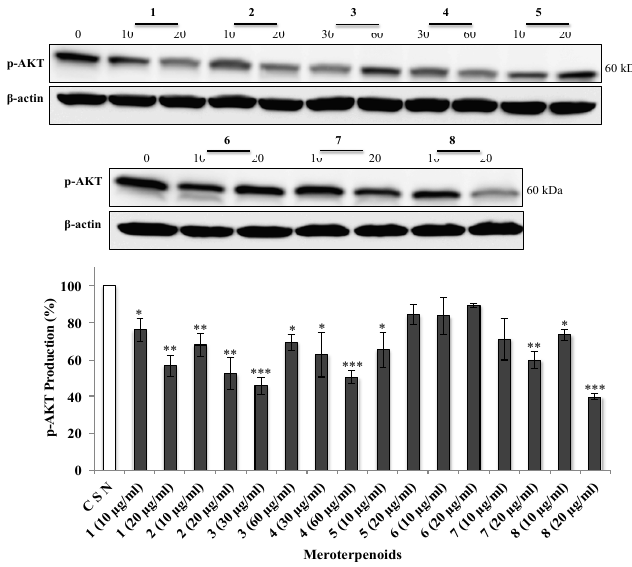
Figure 7. E ff ect of meroterpenes (AMTs) 1-8 on the activation of c-JUN N-terminal kinase (JNK) by measuring expression levels of the phosphorylated form (p-JNK) in HT-29 cells. The cells were treated for 24 h with the compounds (10 and 20 µ g / mL for 1 , 2 , 5 , 6 , 7 , and 8 ; 30 and 60 µ g / mL for 3 and 4 ). The levels of p-JNK were measured by Western blot analysis and quantified with Image J analysis software. The result of control groups was set as 100% activity and test groups were compared to this value. The data shown are the means ± SE of three independent experiments. Significant di ff erences from control group: * p < 0.05, ** p < 0.01, and *** p < 0.001.